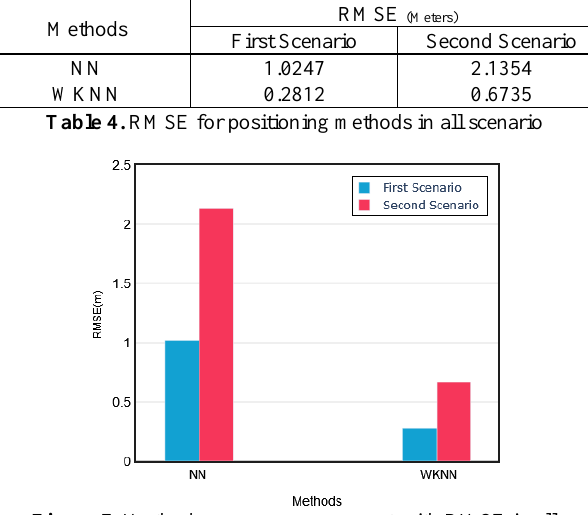
Figure 7 . Methods accuracy assessment with RMSE in all